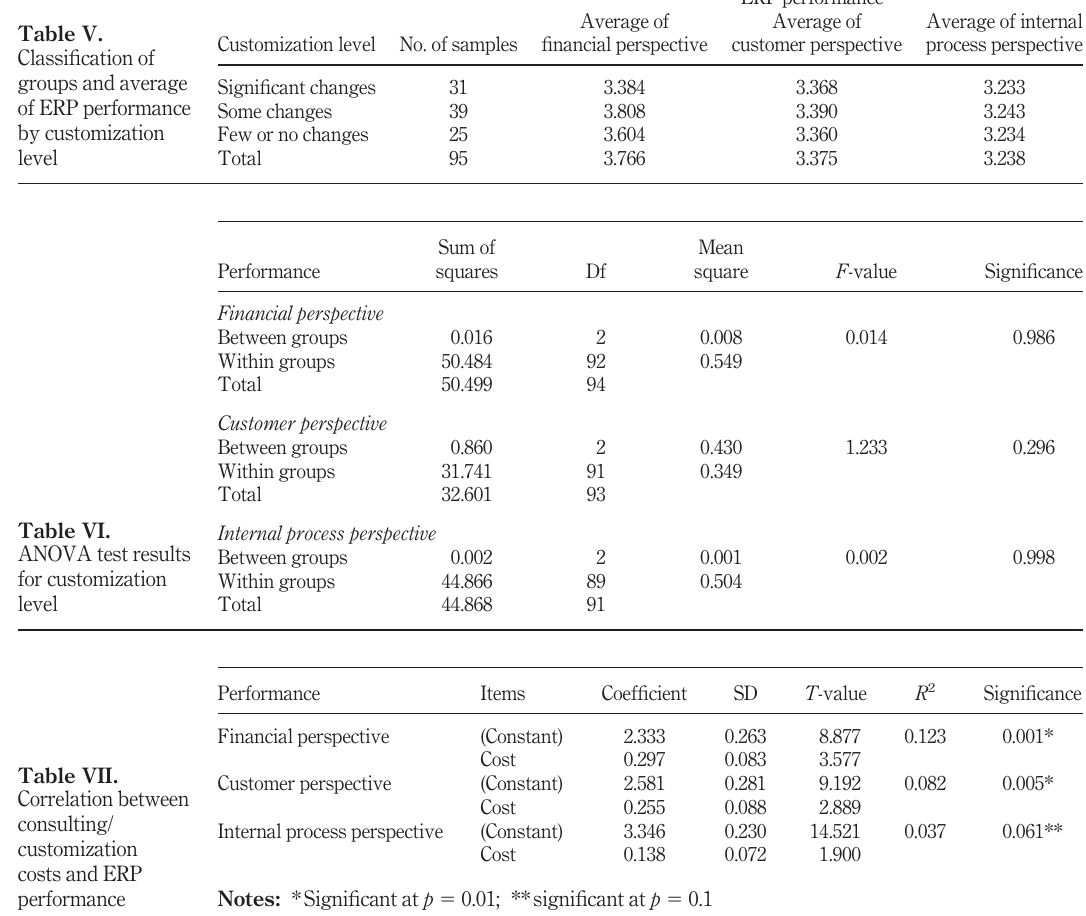
Table V. Classification of groups and average of ERP performance